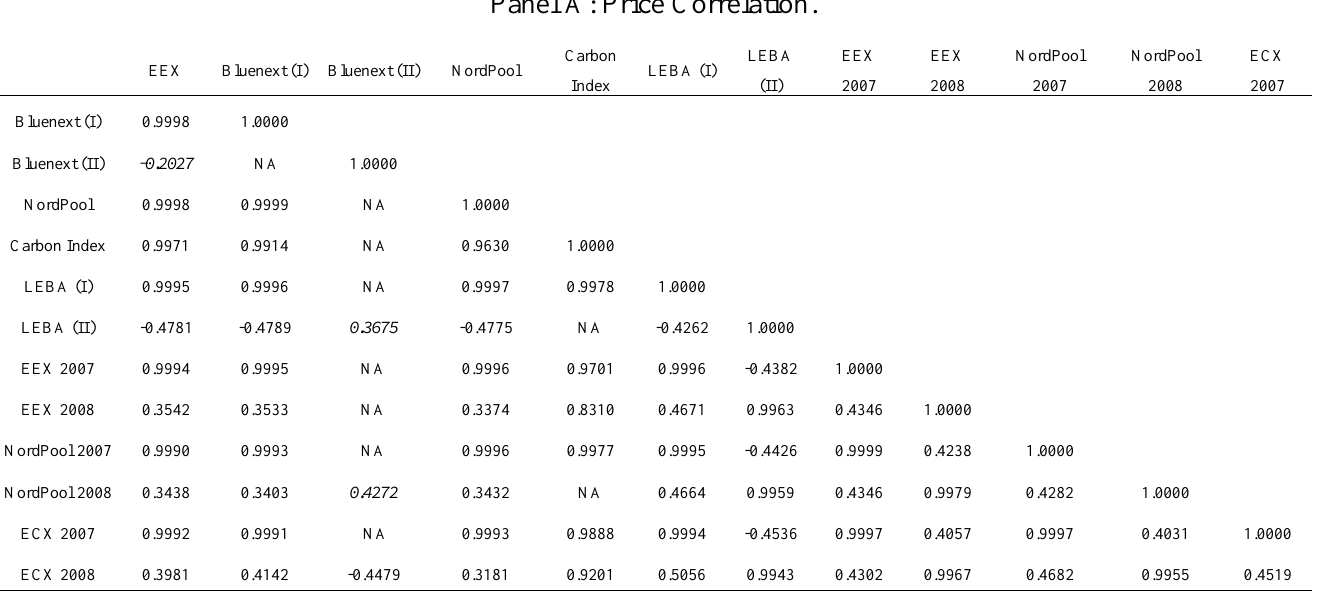
Panel B. Returns